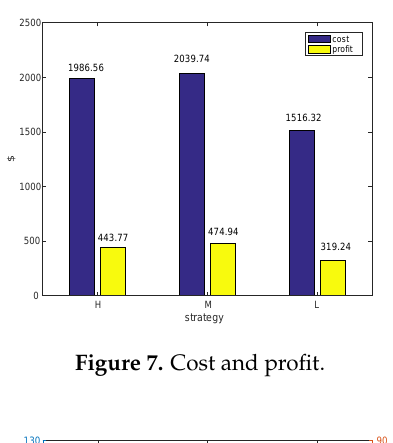
Figure 6. Bidding strategy.